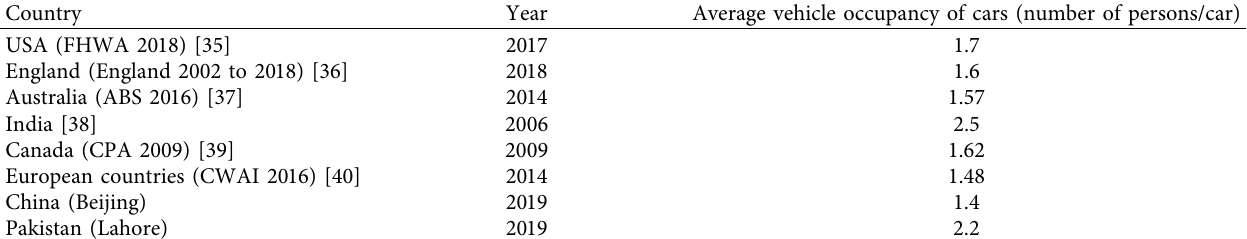
Table 4: Average vehicle occupancy of cars in different countries.